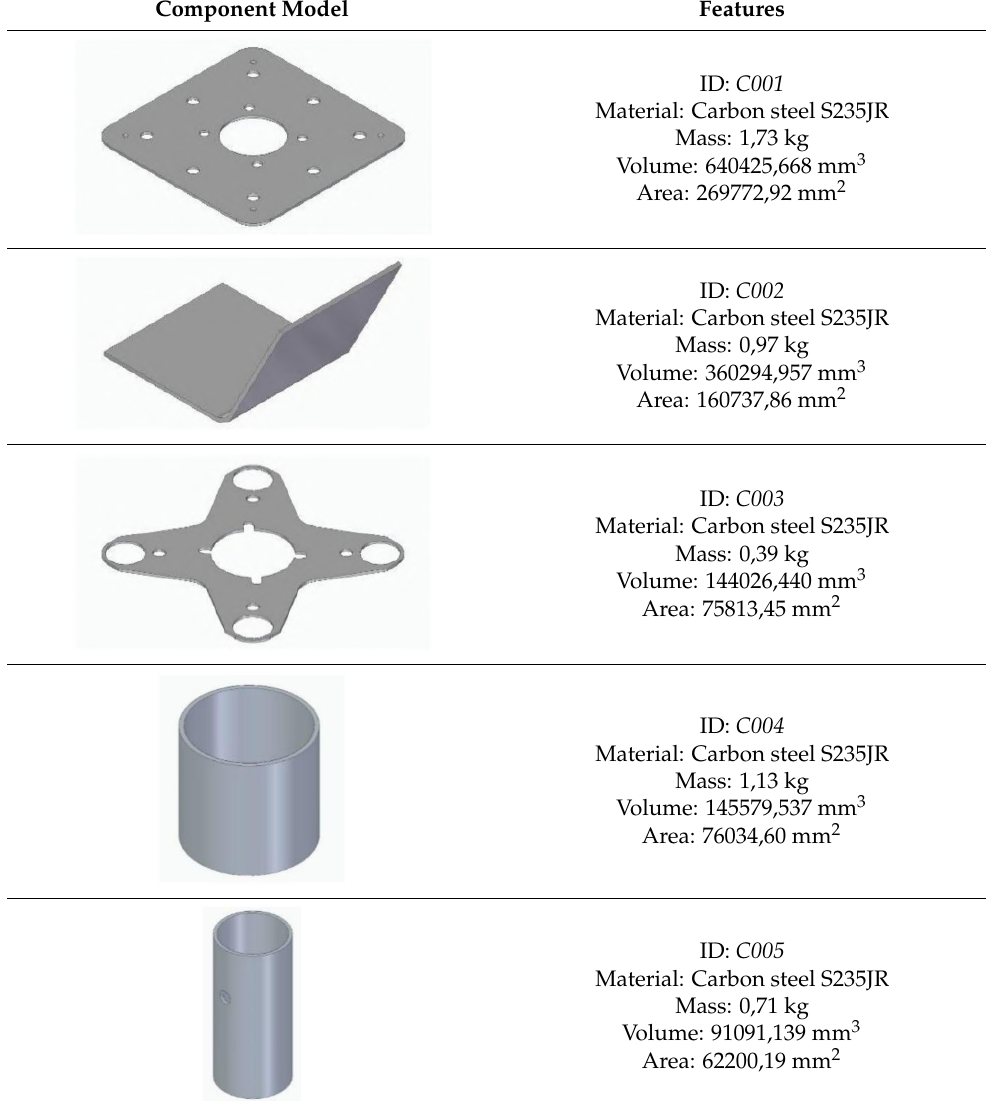
Table 2. Component features extracted by the 3D CAD model of the jack adapter. Component